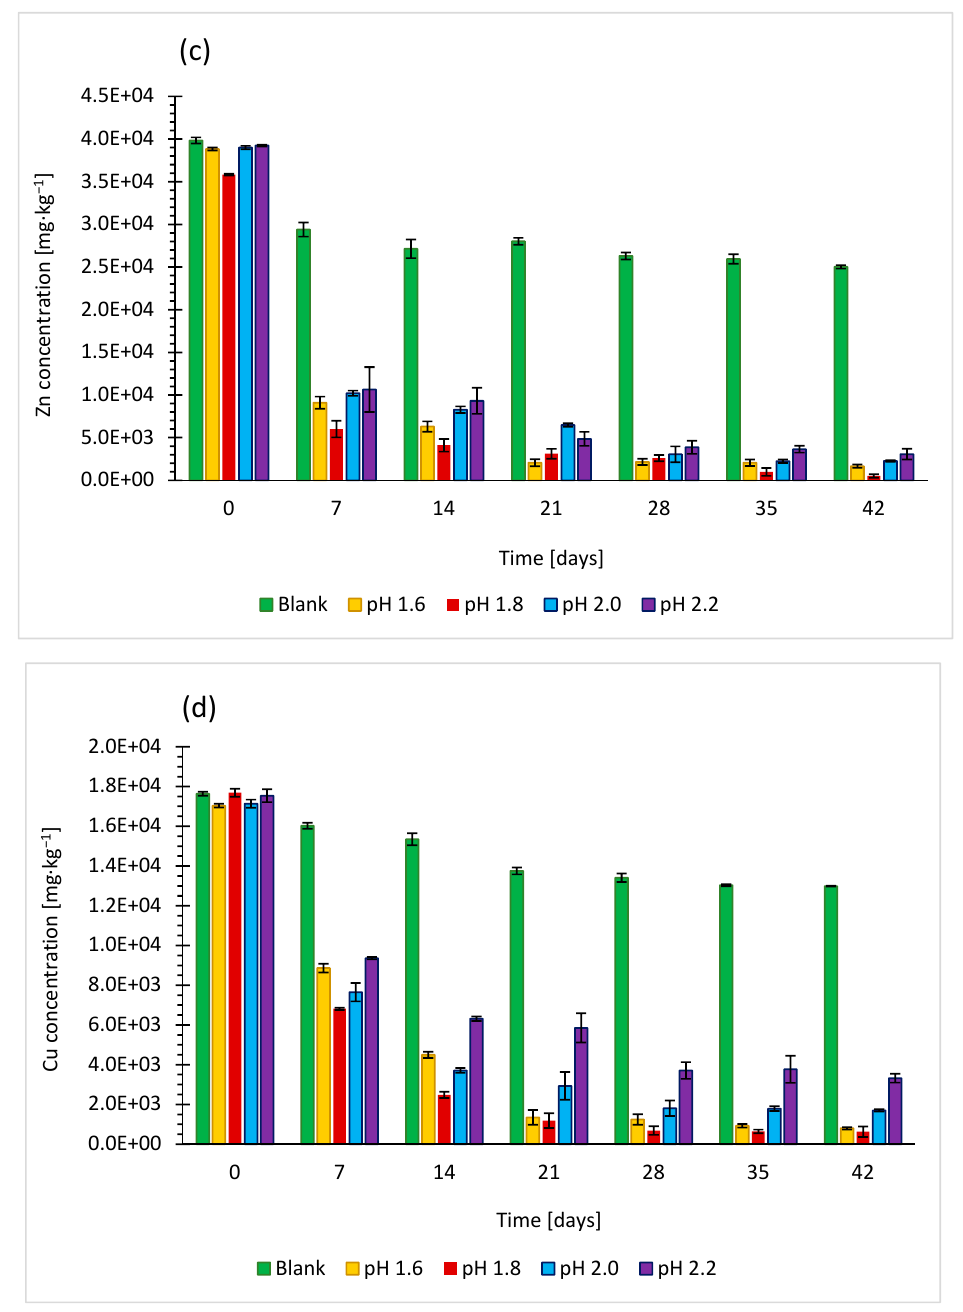
Figure 14. Metal concentrations in solid samples taken during bioleaching at differential pH values for Fe ( a ), Pb ( b ), Zn ( c ), and Cu ( d ).